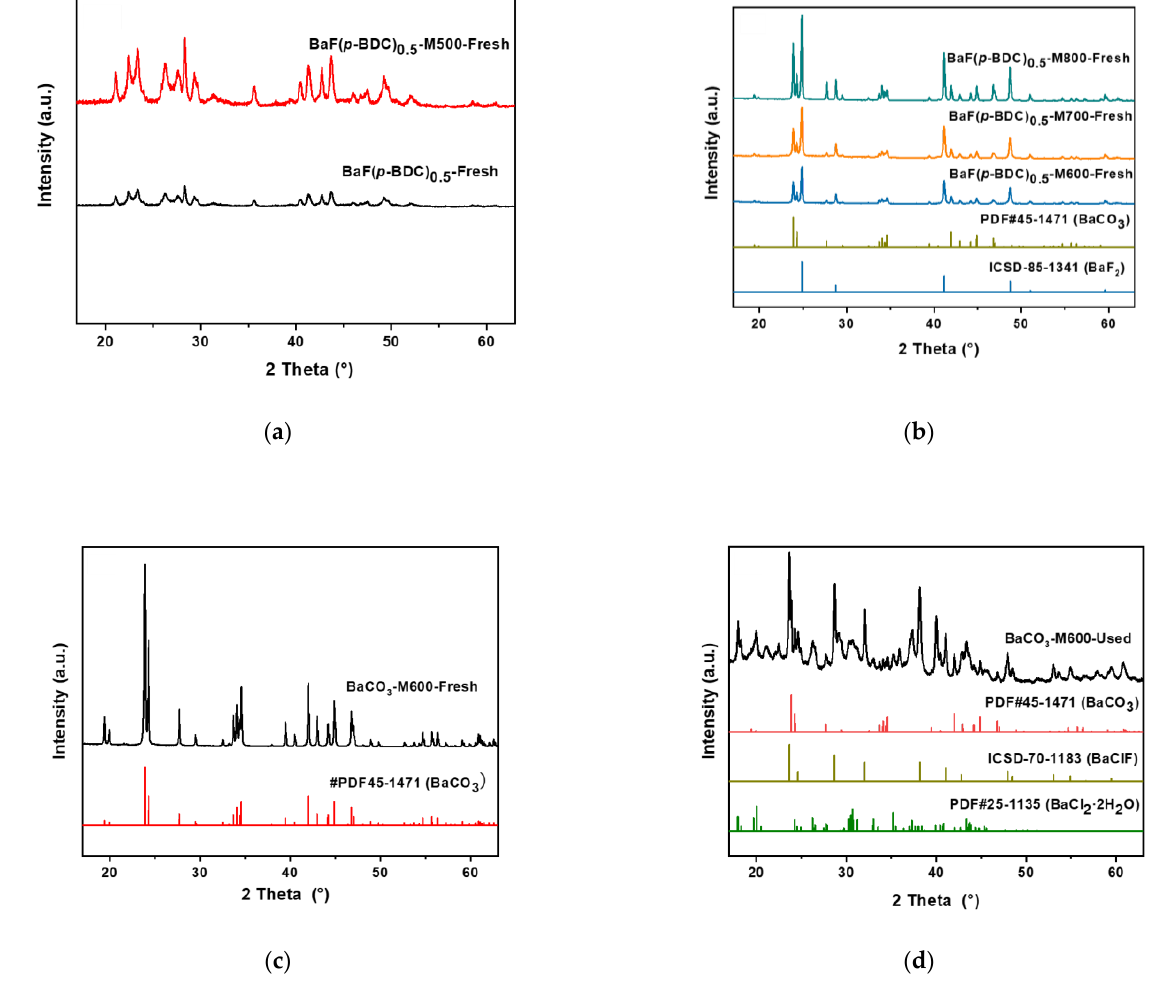
Figure 7. Catalytic performance of BaF( p -BDC) 0.5 -M600, BaF 2 -M600, BaCO 3 -M600, and BaClF-M600 catalysts for the dechlorination of HCFC-142b as a function of time on stream at atmospheric pressure, a gas hourly space velocity (GHSV) of 1200 h −1 , and a reaction temperature of 350 °C. ( a ) Conversion of HCFC-142b, ( b ) Selectivity to vinylidene fluoride (VDF); XRD patterns of fresh ( c ) and used BaCO 3 catalysts ( d ).